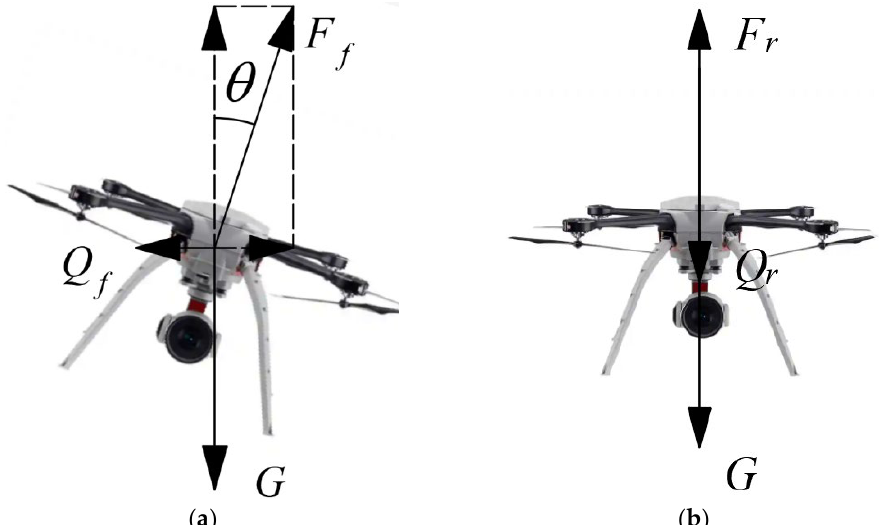
Figure 3. Force analysis of motion for UAV: ( a ) force of forward movement; ( b ) force of rise. G is the force of gravity received by the UAV as it moves. Gravitational acceleration 9.8 / g N kg = and the mass of UAV is m. When the UAV flies in a straight line at v f uniform speed, the angle between the lift direction of the UAV and the weight line is θ , When the UAV rises in a straight line at v r uniform speed, the air resistance Q r is F and the resistance generated by the air is Q the lift force generated by the UAV is f f opposite to its movement direction, which hinders the lift force F r of the UAV. According to Figure 3b, the kinematics equation of the UAV when it is rising at a uniform speed can be shown in Equation